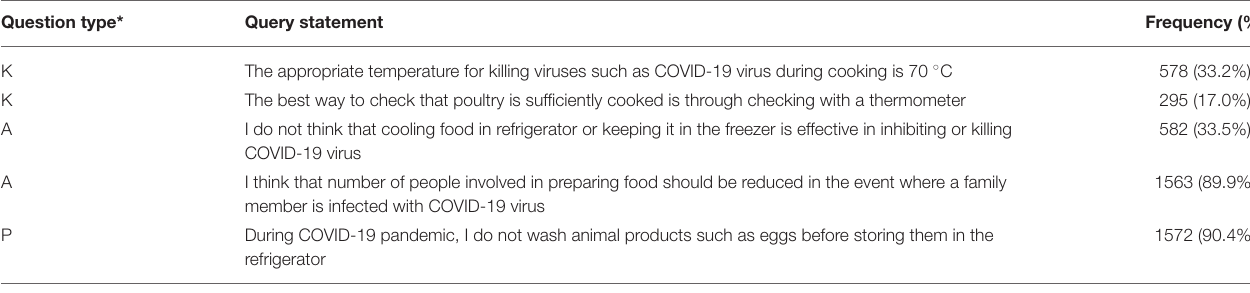
TABLE 3 | Query statements and responses of “food cooking and storage” aspect.